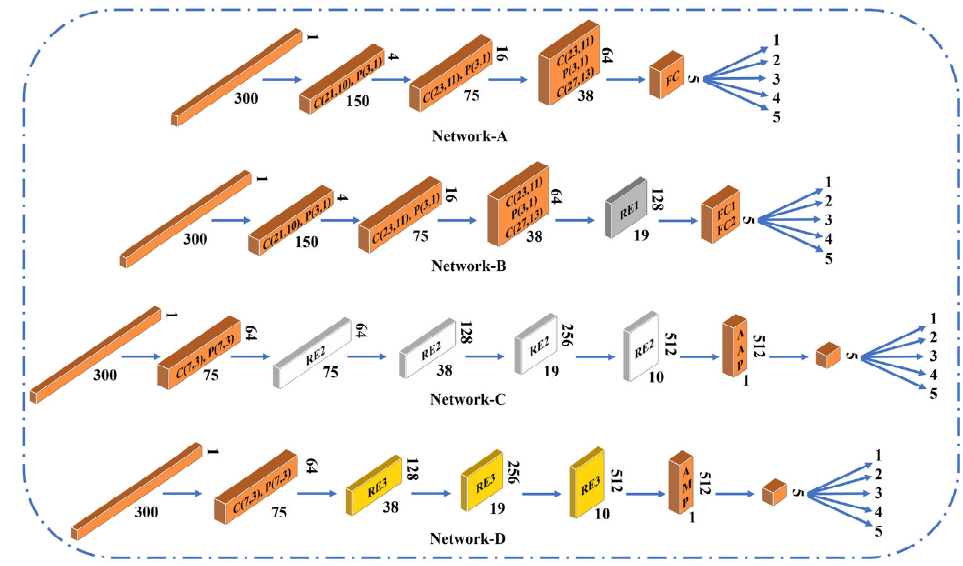
Figure 8. Each network architecture diagram.